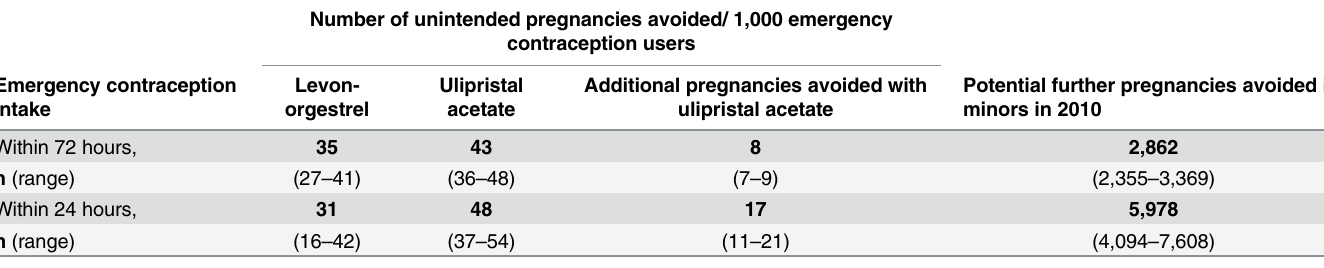
Table 4. Number of pregnancies avoided. Range uses 95% confidence intervals of pregnancy